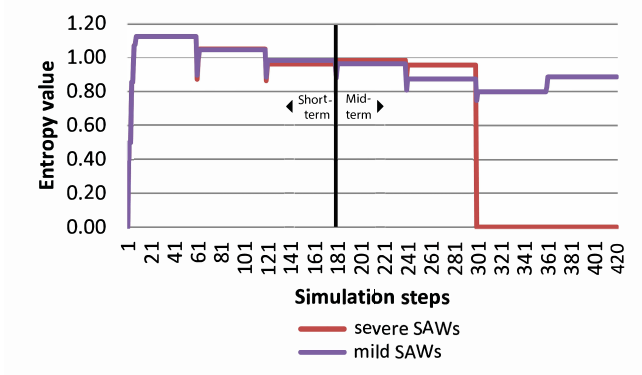
For the VBA simulations, with no particular setup changes in the initialization condi- tions, only two executions were performed applying mild (72%) and severe (82%) percent- ages of digital objects that were affected at each SAW, and both of them can be compared directly in Figure 10. The plot illustrates the average resulting entropy for each simulation when the VBA model was subject to severe and mild SAWs for both the short- (1–15 y) and mid-term (15–35 y).